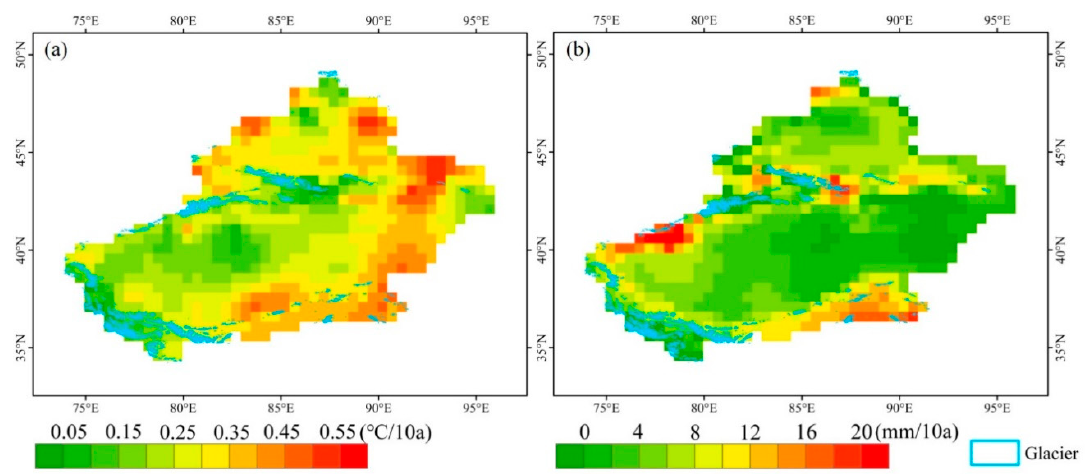
Figure 5. Spatial changes in the ( a ) annual mean temperature and ( b ) annual precipitation in Xinjiang from 1961 to 2018.